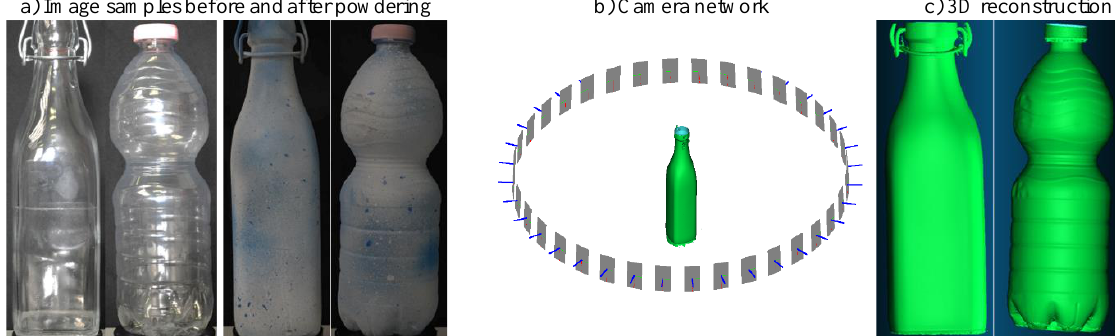
Figure 1. 3D reconstruction results for a glass bottle (400x80x80 mm) and a plastic bottle (300x70x70 mm) (a) using photogrammetry and 36 images (ground sample distance – GSD ≈ 38 µm) acquired with a turntable (b). Without powdering, no results are achieved. Only after powdering a successful 3D result can be obtained